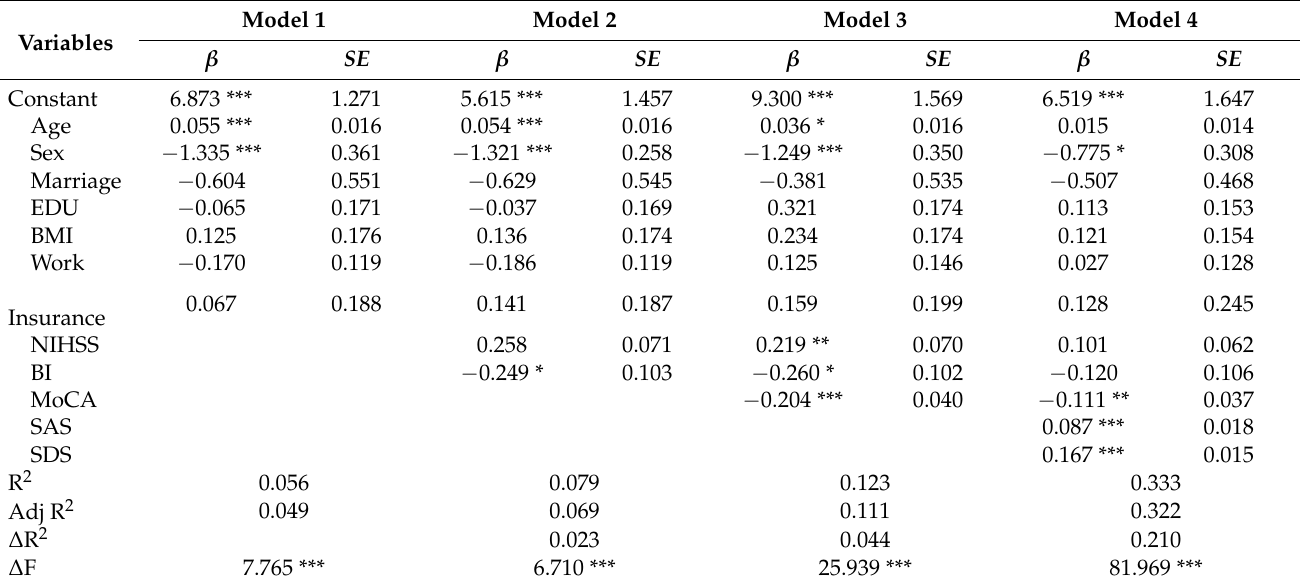
Table 2. Association between sleep quality and related influencing factors in IS